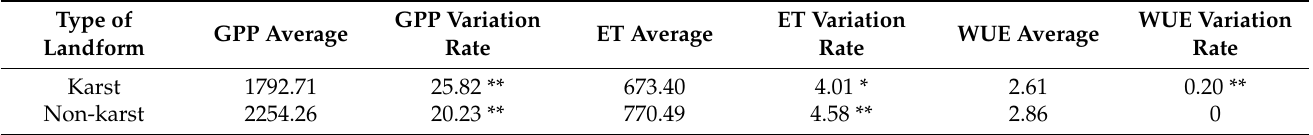
Table 1. Mean values and variation rates of GPP, ET, and ecosystem WUE in karst and non-karst